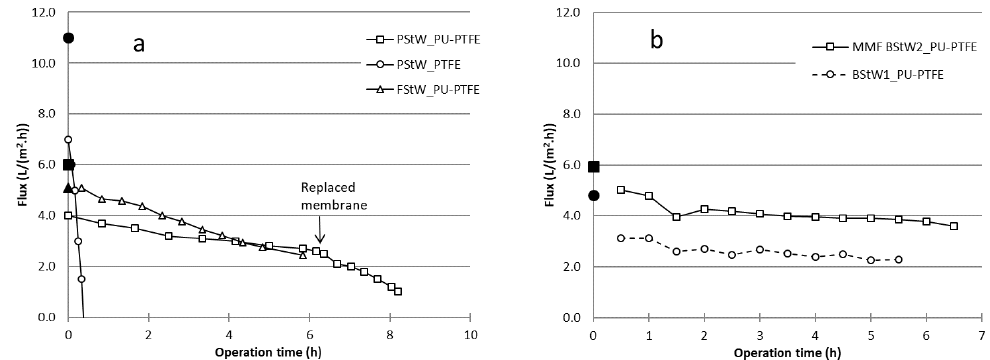
Figure 2. Total flux of MD tests as a function of time for PStW and FStW ( a ), and BStW ( b ) samples. Open symbols show sample MD test results, and solid symbols on t = 0 axis show initial clean water flux. MD hot (feed) cycle temperature = 60 °C, cold (permeate) cycle temperature 20 °C, cycle flow rates = 545 mL/min.